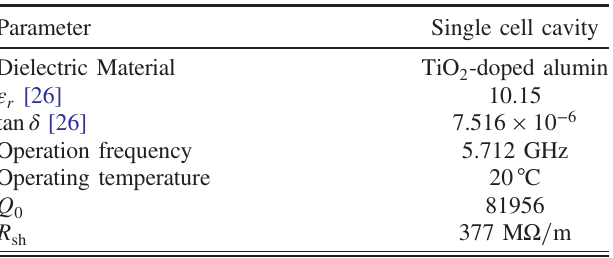
TABLE I. The parameters of the accelerating structure that is illustrated in Fig. 8.